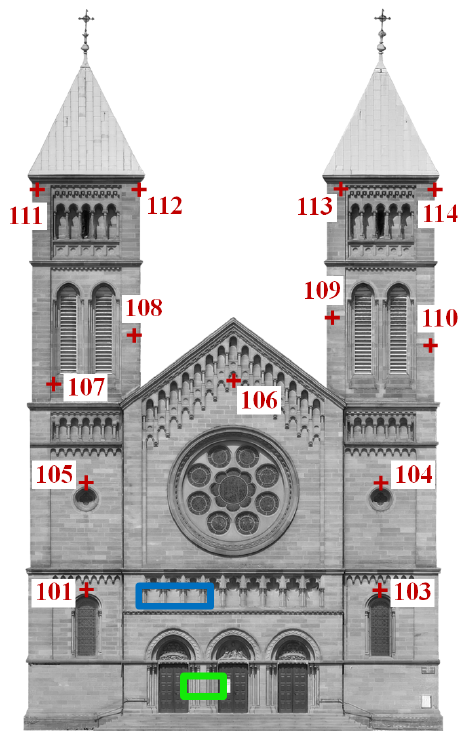
Figure 4. Distribution of the Ground Control Points (GCP) on the facade. Blue and green rectangles highlight architectural ele- ments used for comparisons in next sections.